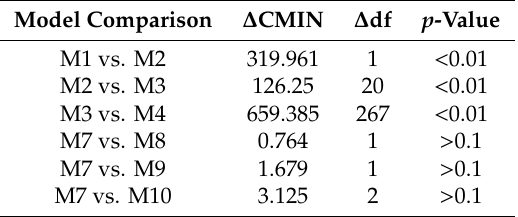
Table 3. Chi-squared test of nested SEM